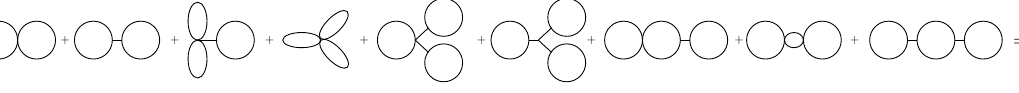
Figure 4 . Type of UV divergent diagrams that mutually cancel at order O ( β 4 )